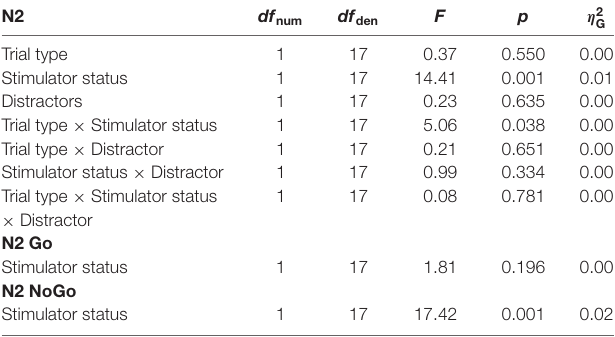
η 2 G = Generalized Eta Squared; df, degrees of freedom.